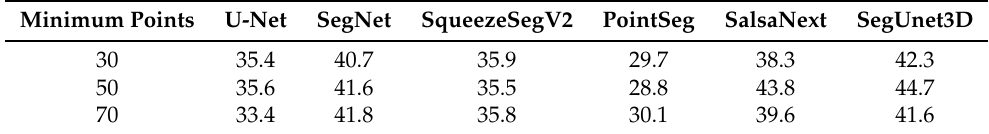
Table 3. Results of different segment size on SemanticPOSS. The values are in %. Minimum Points